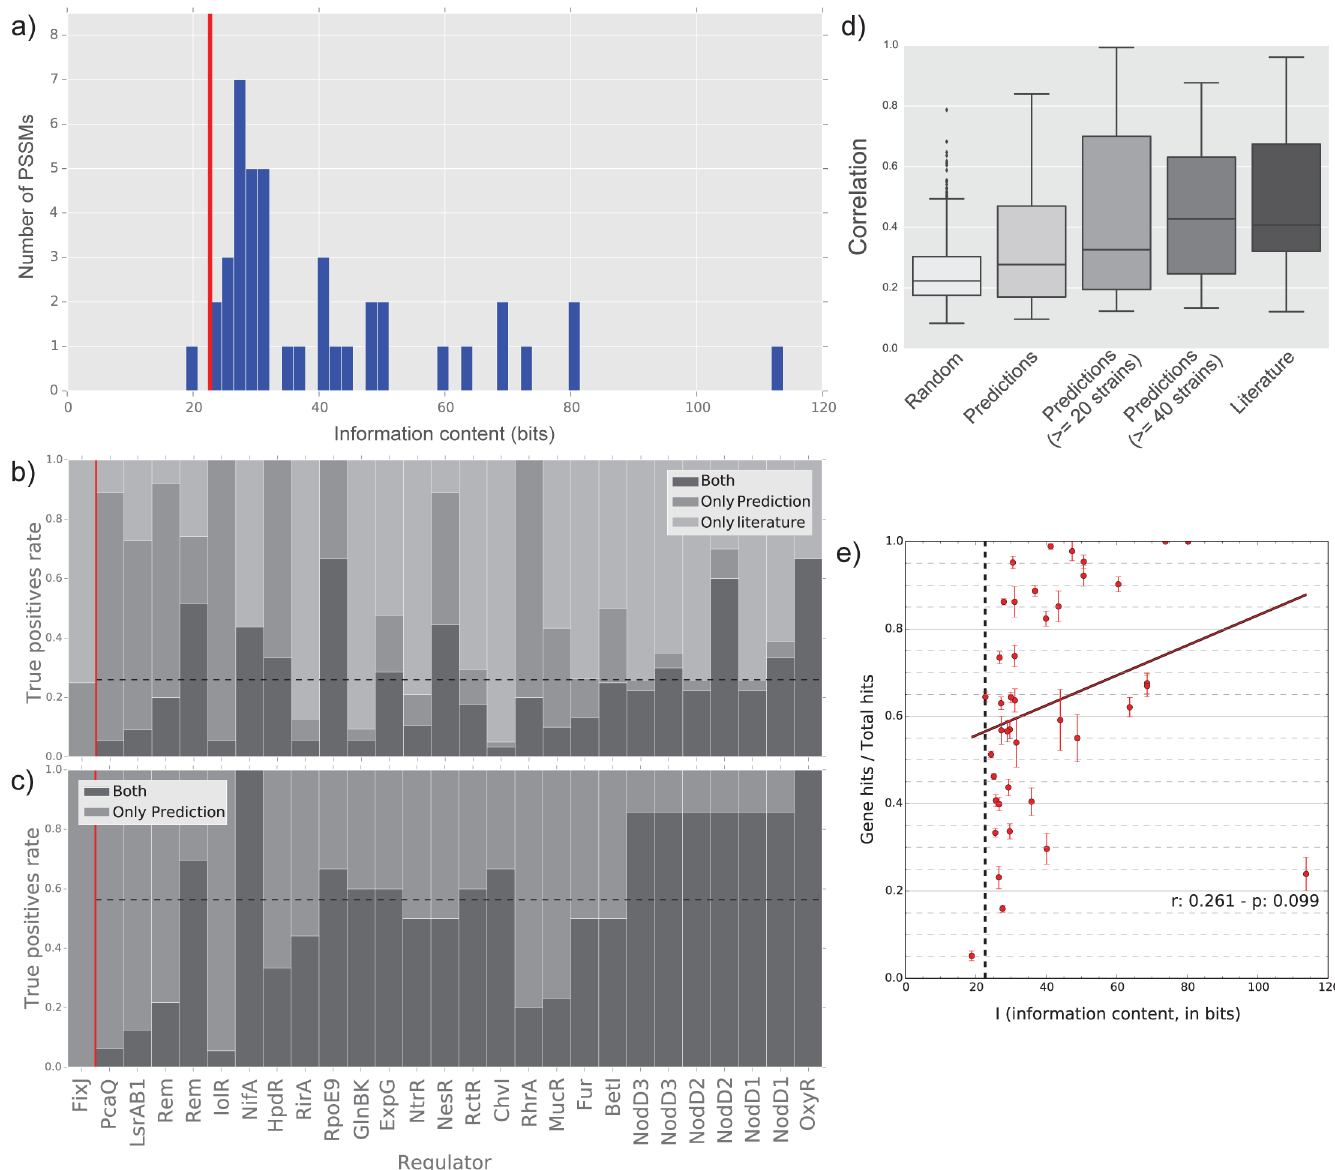
Fig 1. General characteristics of the presented TF predictions and quality control. a) Information content frequencies for the 41 analysed TFs: vertical line indicates the minimum information content, as measured for S. meliloti strain Rm1021; b-c) comparison between TFBS predictions and the reported experimental results in strain Rm1021: the dashed horizontal line indicates the mean value for the TFs with information content higher than the minimum value; d) correlations with the COLOMBOS expression compendium for S. meliloti Rm1021; e) correlation between the TFs information content and the signal-to-noise ratio, measured as the proportion of prediction in genes upstream regions over the total number of predictions: vertical bars indicate the error level measured in all the strains.